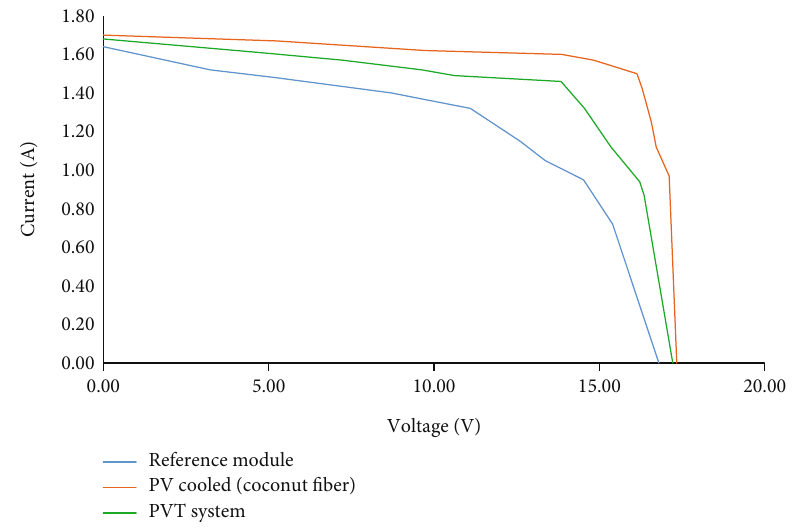
Figure 5: Comparison of output current and voltage between PV